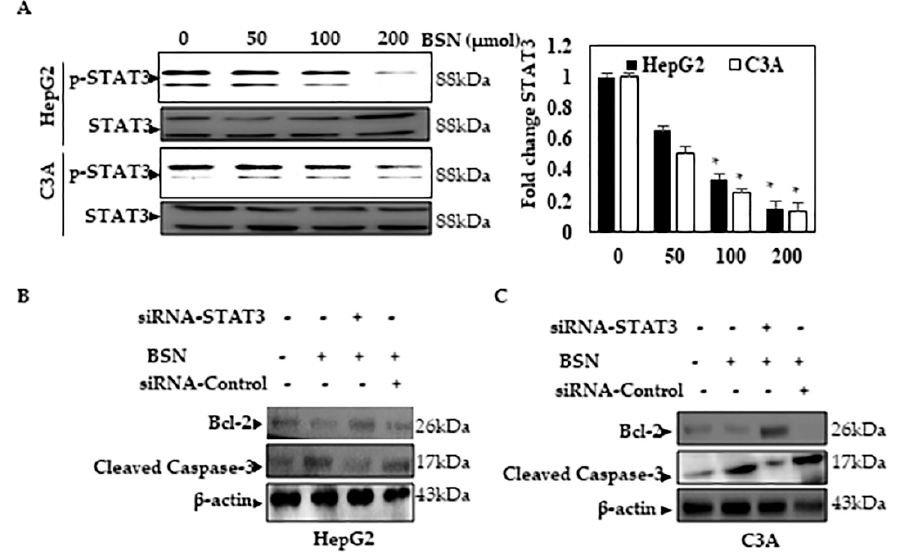
Figure 4. BSN induced apoptosis by downregulating STAT3 signaling pathways in hepatic carcinoma cells. ( A ) We treated HepG2 and C3A cells with 0–200 µ mol BSN for 4 h. Prepared whole-cell extracts and used anti- p -STAT3 antibody to perform Western blotting. The results were from three independent experiments. ( B , C ) Silencing STAT3 aborted BSN-mediated apoptosis. A specific SAT3 siRNA or control siRNA were transfected into cells. The cells were transfected and incubated with or without BSN (200 µ mol) for 48 h. Western blotting was used to measure STAT3 transcriptional targets such as Bcl-2 and cleaved caspase-3. Experiments were conducted in triplicate. Tukey’s post hoc test was used in this study to analyze the data. p < 0.05 was considered significant. Graph Pad prism was used. Data are presented as the mean ± SD. Furthermore, * p < 0.05 vs.